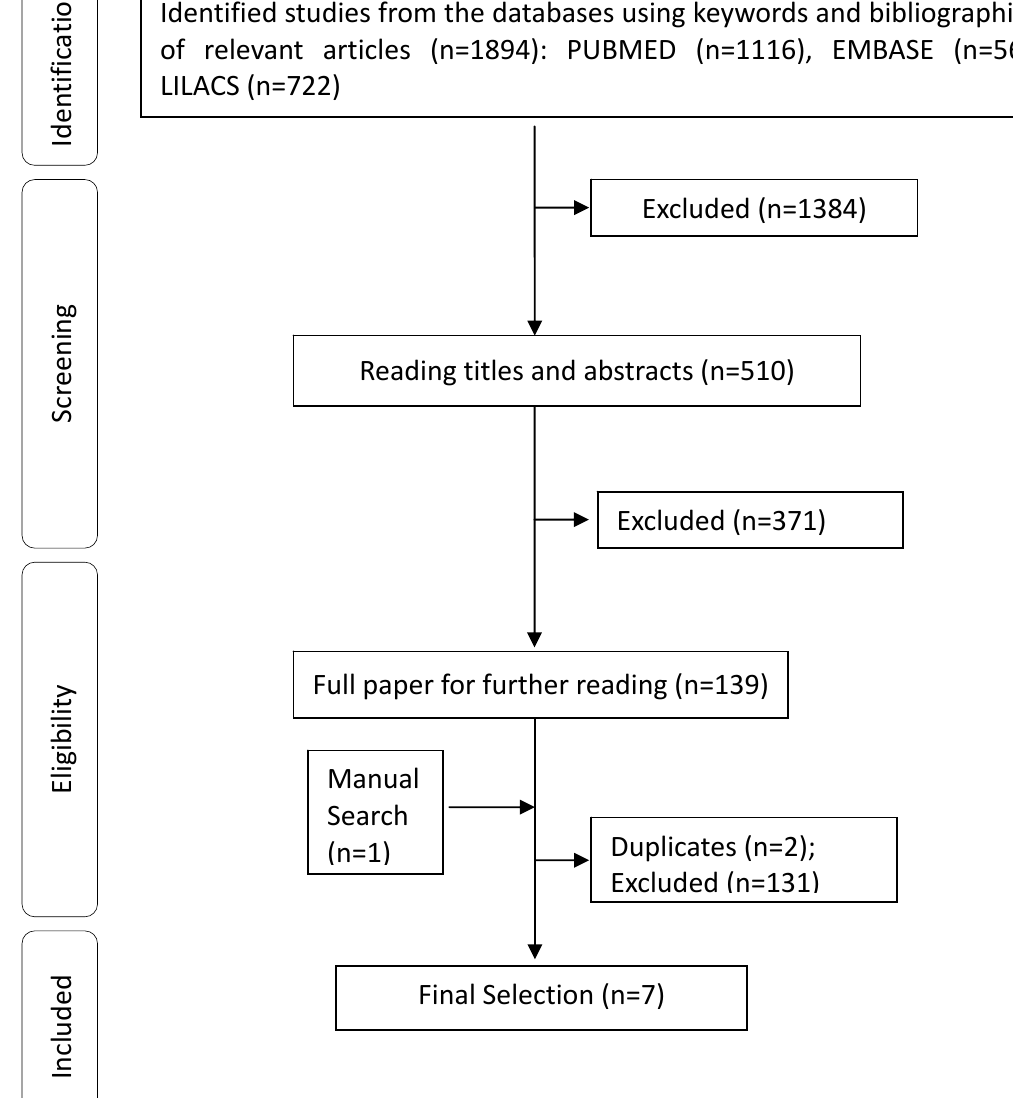
Figure 1. Flowchart of included studies. Studies were excluded according to the following exclusion criteria: studies in humans, studies of mixtures of substances or extracts from plants, review articles, meta-analyses, abstracts, conference proceedings, editorials/letters, case